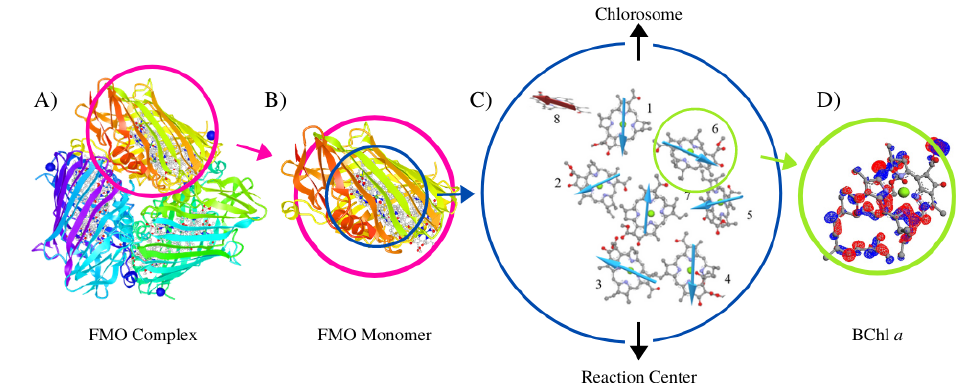
Figure 5. FMO from Prosthecochloris aestuarii . ( A ) Complete structure of the protein trimer. ( B ) Close-up to a single monomer. ( C ) The eight numbered chromophores in the monomer exhibiting their localized dipolar momenta. ( D ) A single BChl molecule, one of the eight chromophores in each monomer. Figure produced from Protein Data Bank file 3EOJ